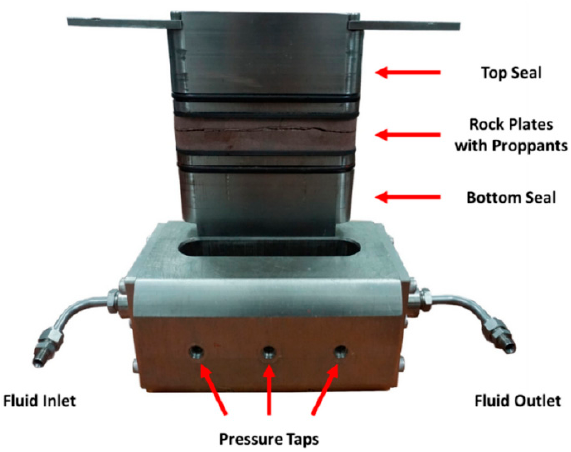
Figure 1. A typical fracture conductivity cell